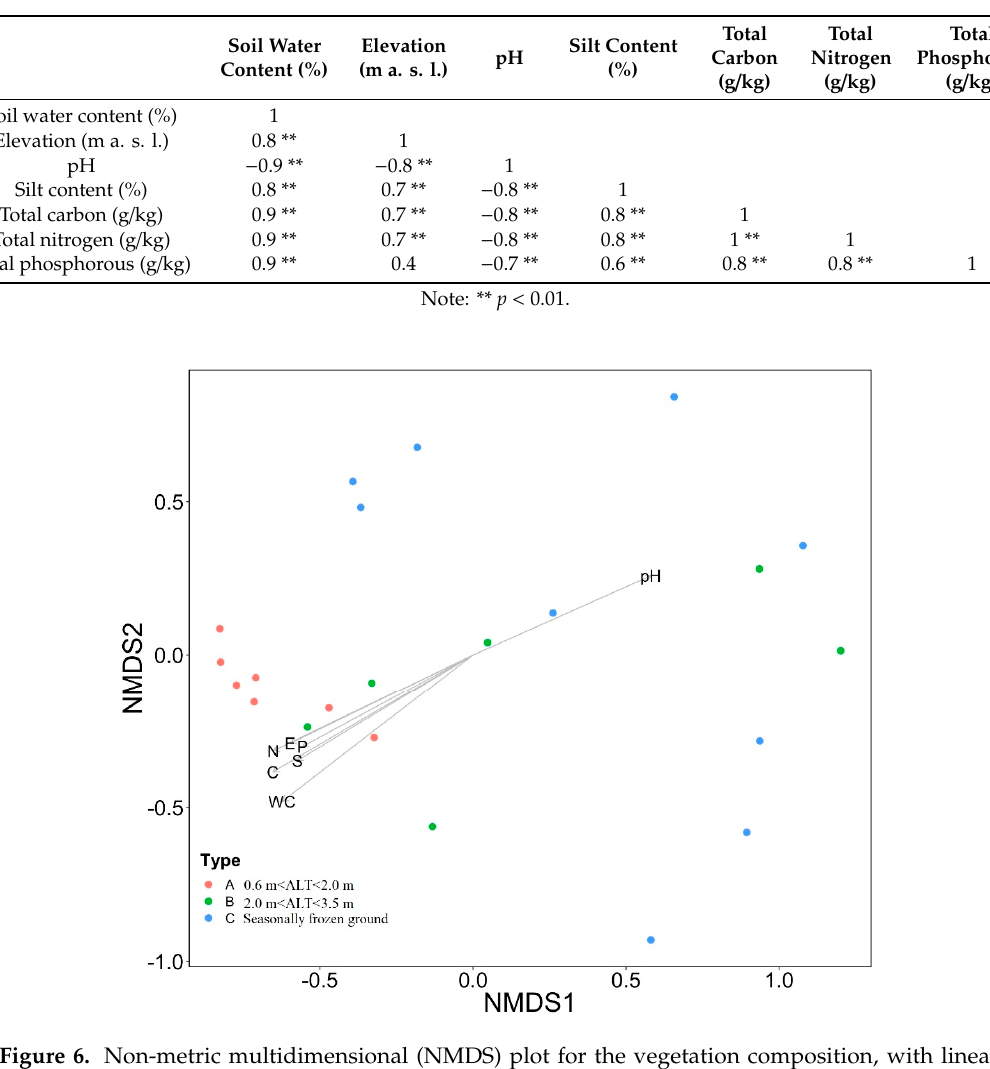
Table 5. Correlation between environmental factors. N = 22, including sites in frozen ground areas.